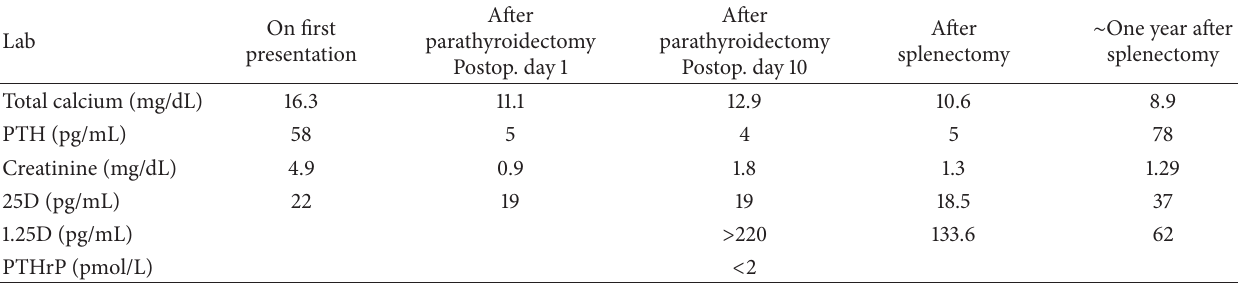
Table 1: Pertinent labs before and after parathyroidectomy and resection of the spleen.